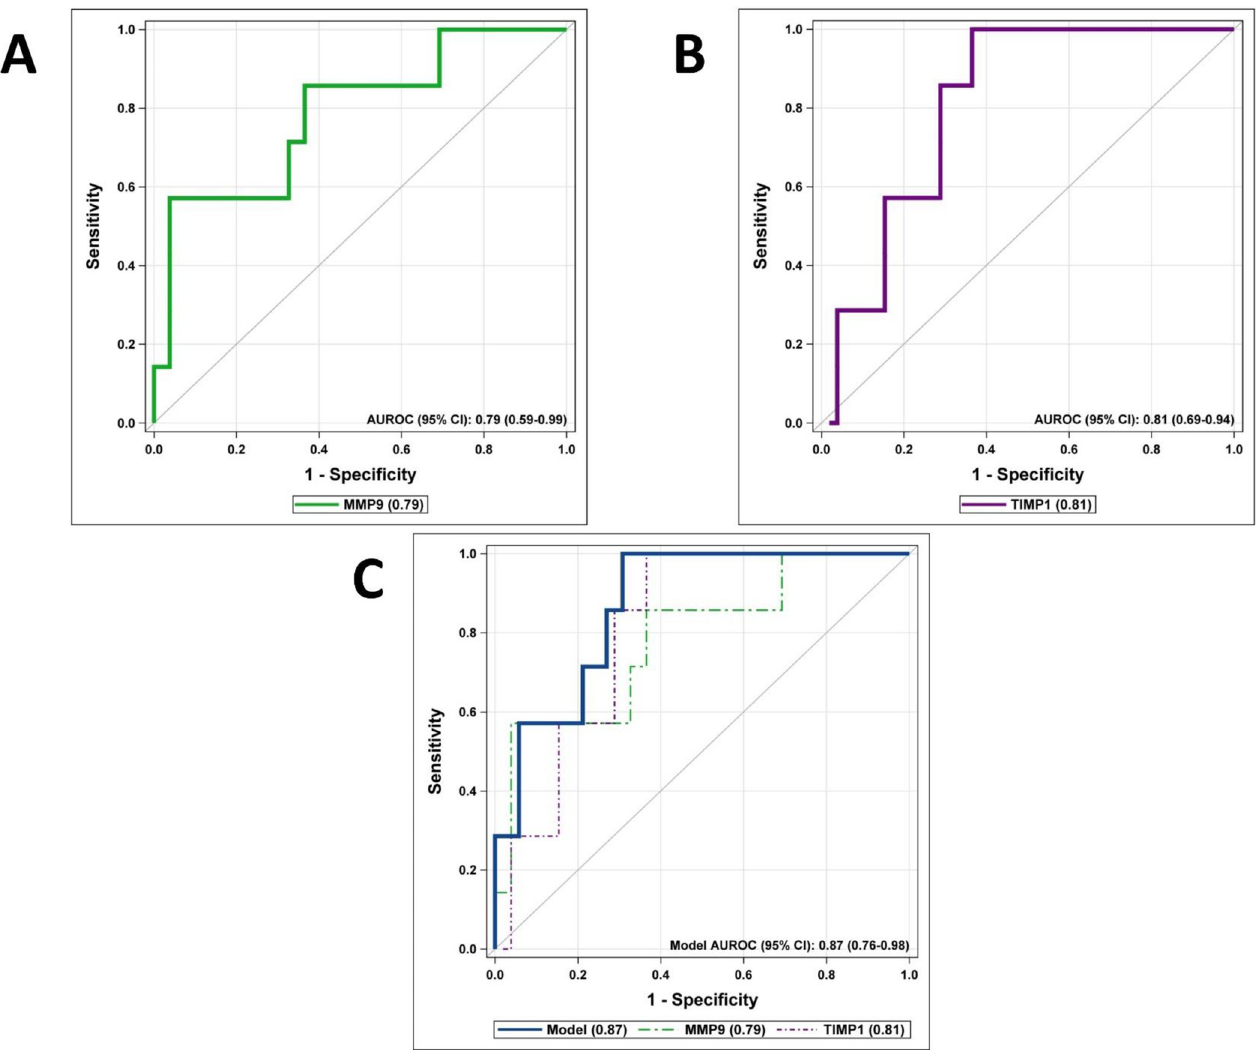
Fig 4. Detection of SAP using receiver operating curves (ROC). ROC curves demonstrating ability of MMP-9 (Fig 4A, p = 0.02) and TIMP-1 (Fig 4B, p = 0.04) to predict SAP. Fig 4C demonstrates a multivariable logistic regression model using both MMP-9 (p = 0.02) and TIMP-1 (p = 0.03) as predictors. SAP = severe acute pancreatitis. MMP = matrix metalloproteinase. TIMP = tissue inhibitor of matrix